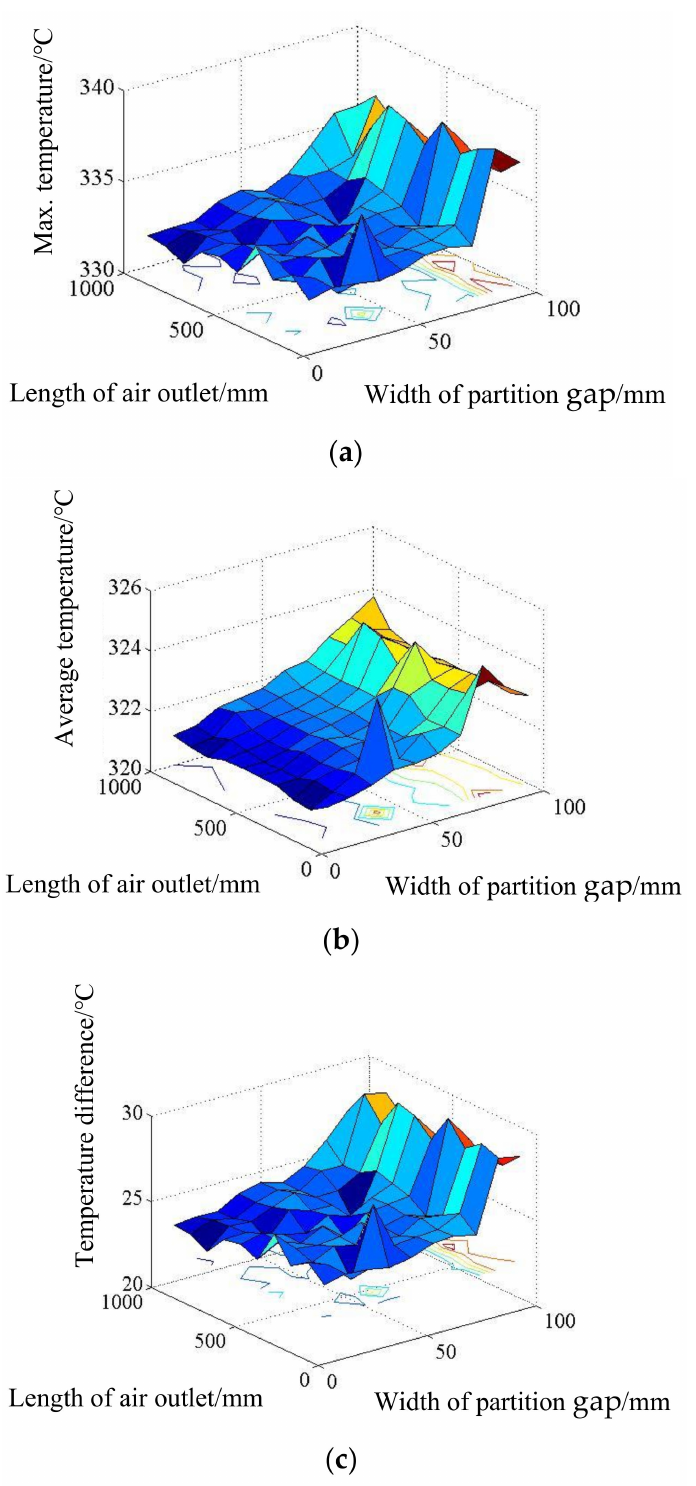
Figure 13. ( a ) The maximum temperature variation curve of the battery pack; ( b ) the average temperature variation curve of the battery pack; and ( c ) temperature difference variation curve of the battery